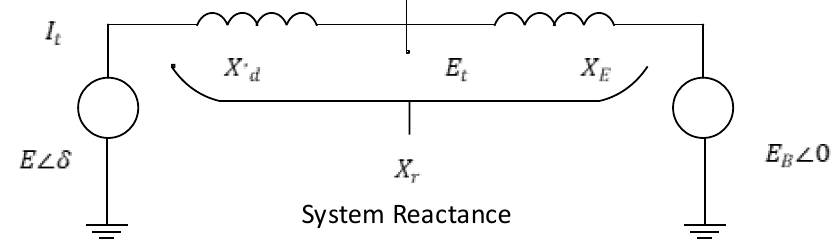
Figure 1. Classic model diagram in a Single Machine Infinite Bus (SMIB) system .